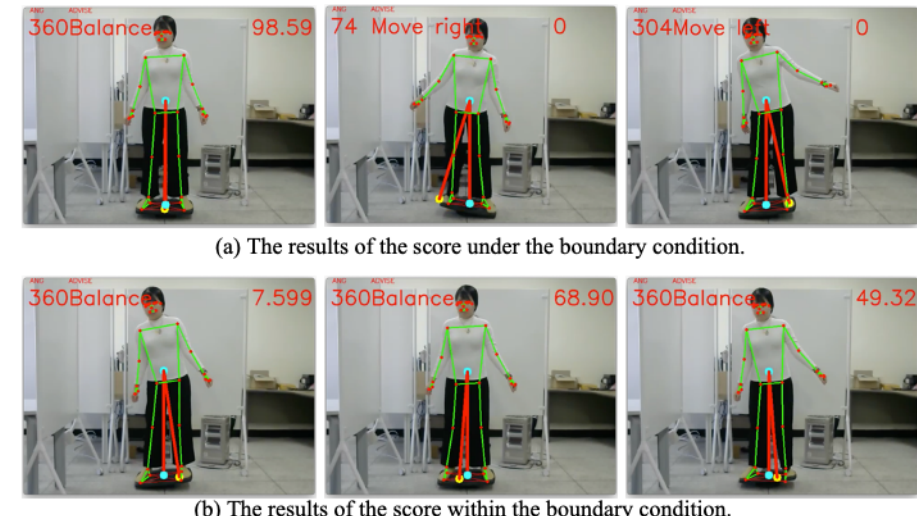
Figure 8. The results of some examples to score the human body-balance ability on the wobble board (HBBAWB) based on the geometric solution: ( a ) represents the results under the boundary condition and ( b ) represents within the boundary